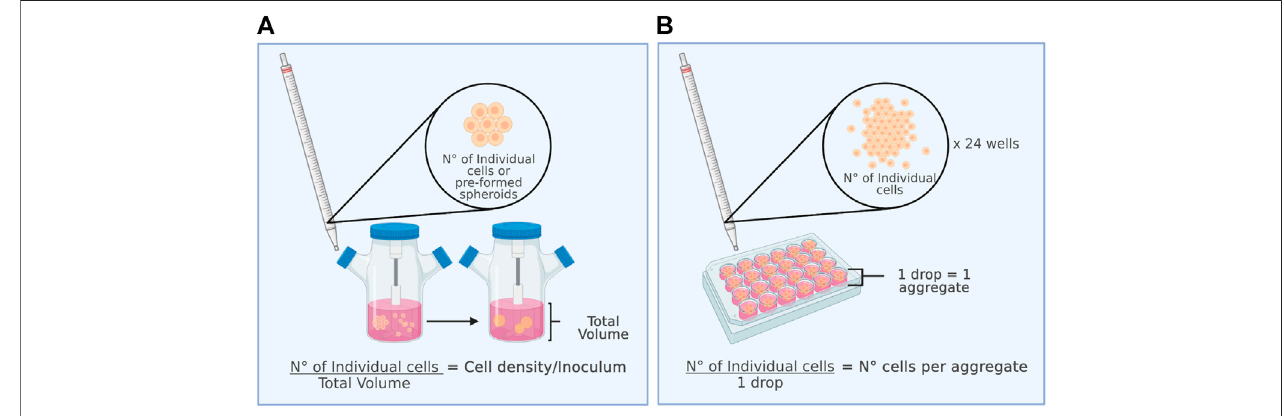
FIGURE 2 | The inoculum is a key parameter for the dynamic culture of spheroids. (A) (Left fi gure) Initial cell density and (B) number of cells per aggregate.